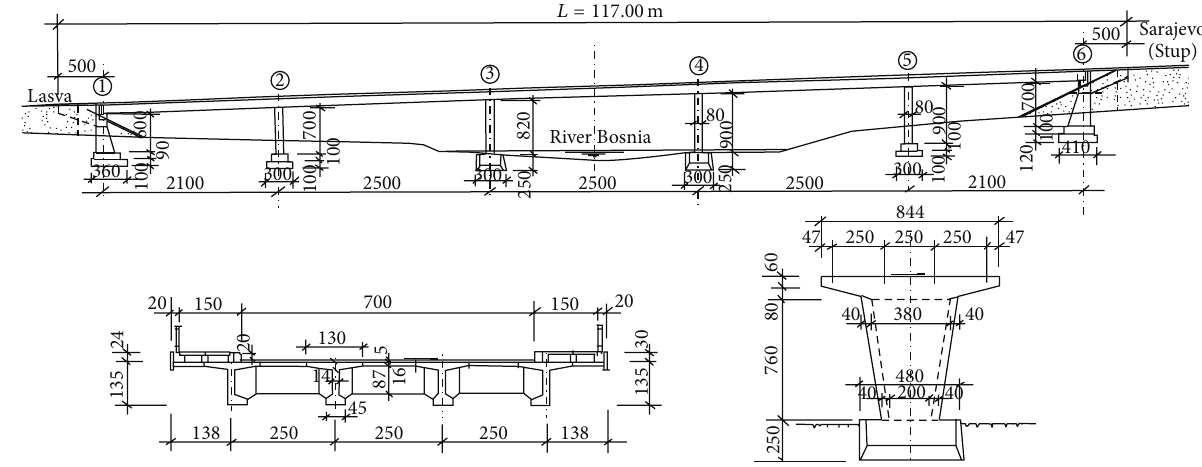
Figure 2: Elevation and cross sections of the bridge.